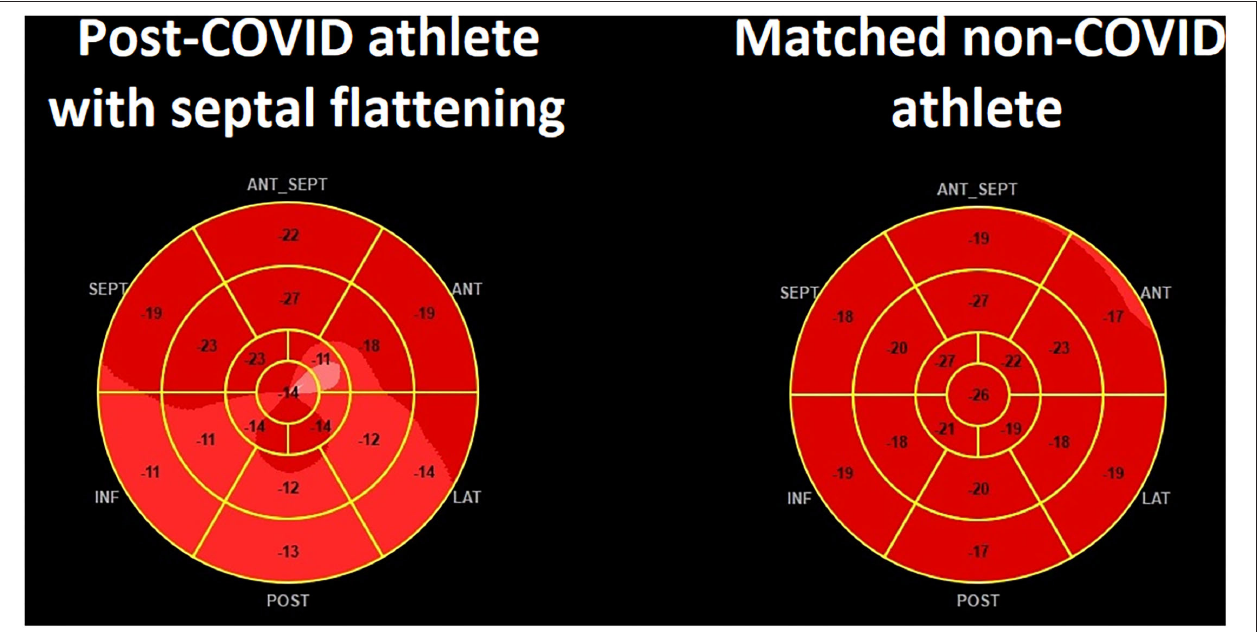
FIGURE 3 | The “Hot Septum Sign” in a post-COVID athlete with septal flattening. While left ventricular global longitudinal strain is preserved, a relative decrease in the free wall segments can be noted (left), suggestive of a characteristic feature of pericardial constriction. In the matched control, segmental strain values of the septum and free wall do not markedly differ